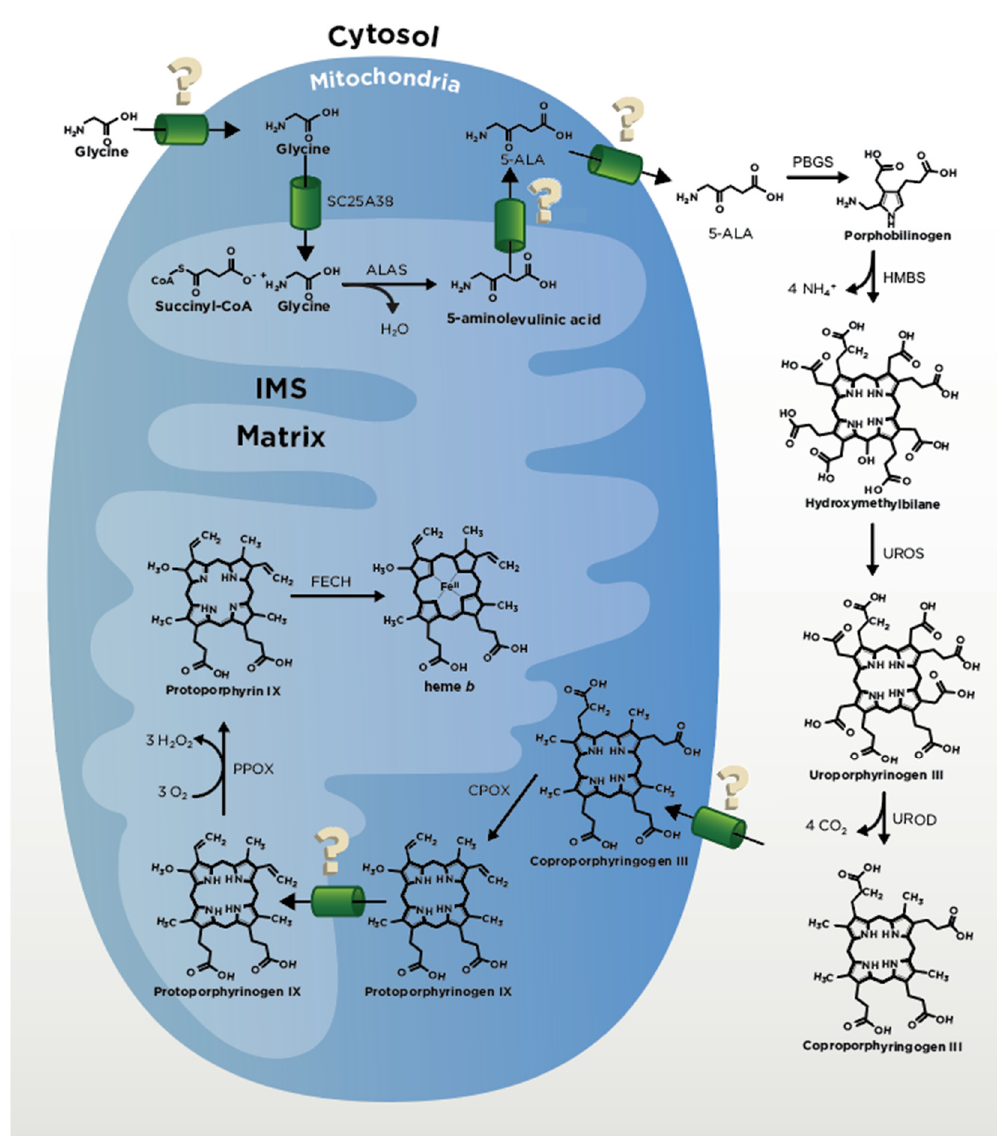
Figure 2. Structures and enzymes involved in heme synthesis shown where they are localized. Glycine is transported into the intermembrane space of the mitochondria (IMS) through an unknown mechanism and is transported across the inner mitochondrial membrane (IMM) by